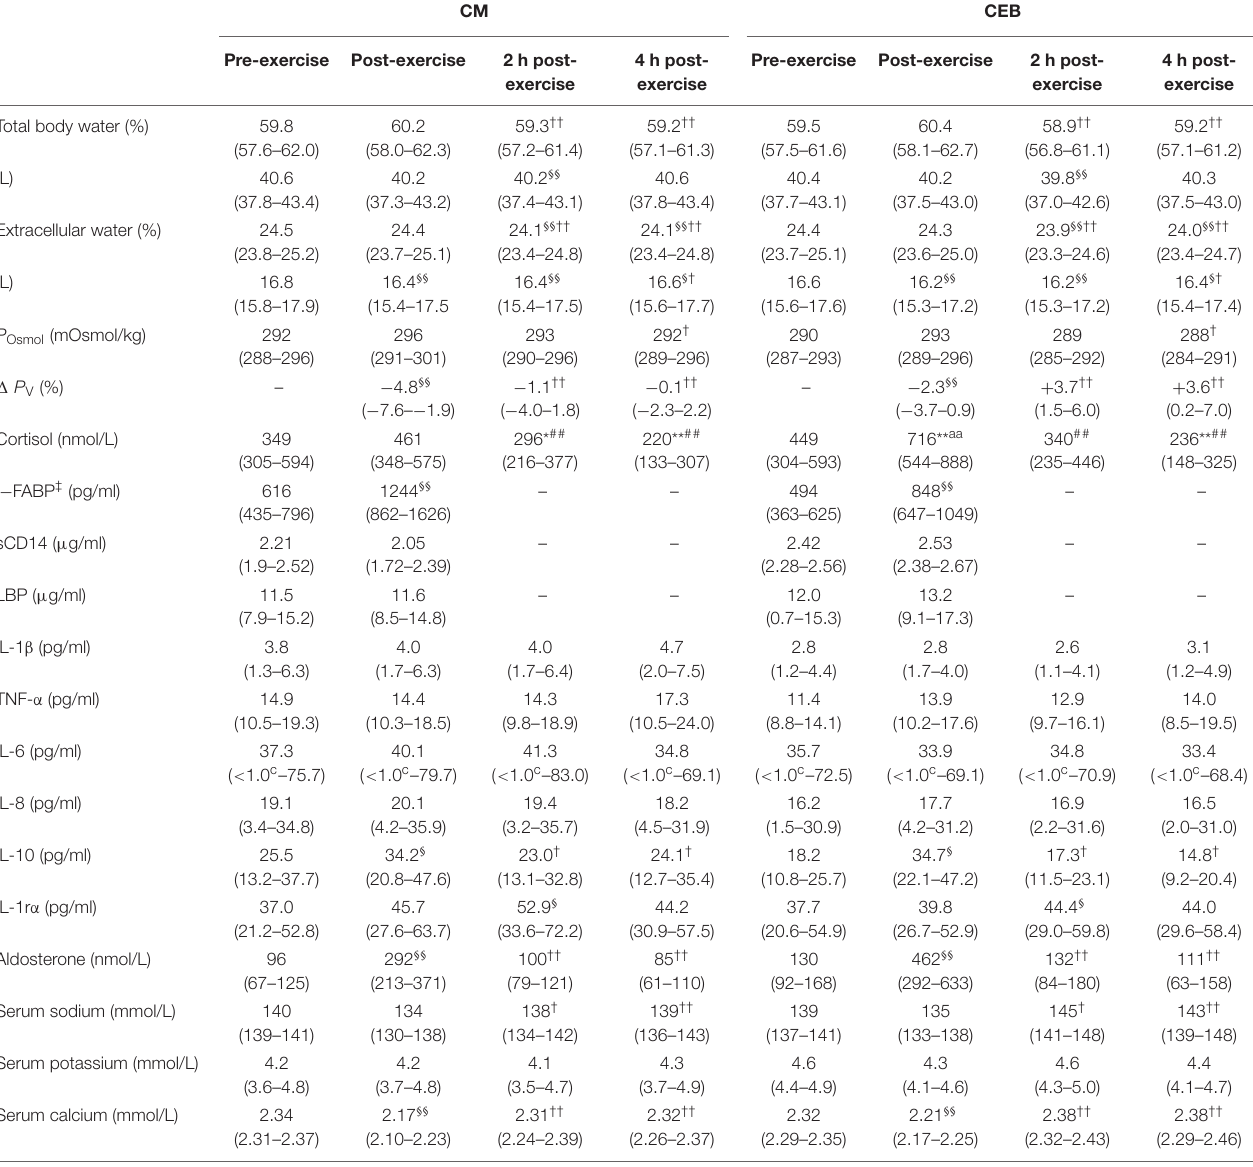
TABLE 1 | Change in hydration and recovery optimization biomarkers in response to 2 h HIIT exercise (between 60 and 80% ˙V O 2max ) in temperate ambient conditions and after consumption of dairy milk (CM) and carbohydrate-electrolyte (CEB) recovery beverages.